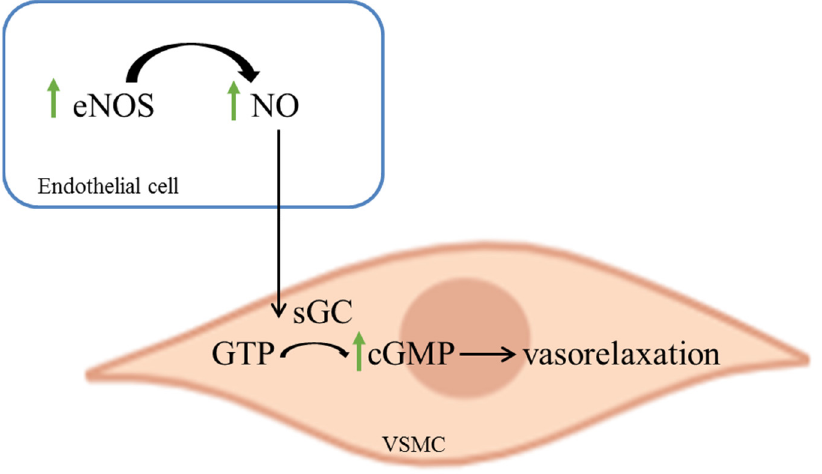
Figure 6. Schematic diagram of the mechanism of bee bread (green arrowhead) induced vasorelax- ation in the isolated aorta of obese rats. eNOS: endothelial nitric oxide synthase, NO: nitric oxide, GTP: guanosine triphosphate, cGMP: cyclic guanosine monophosphate, VSMC: vascular smooth muscle cell.